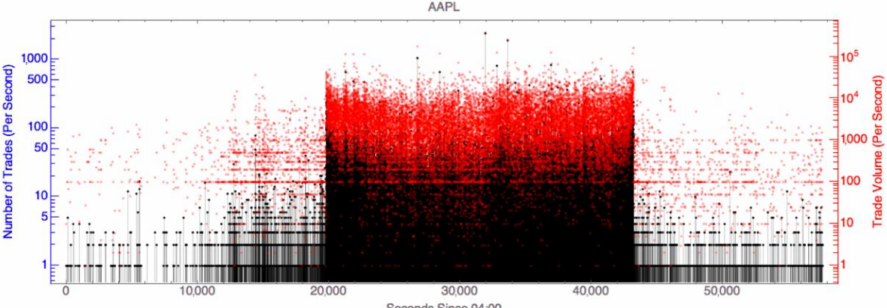
Figure 5. Trades in Apple stock on 11 August 2015 at each second of the day from 04:00 until 20:00. To get a sense of how much capital is circulating, a look into the number of dollars traded $40 million in Apple stock is traded in one second.